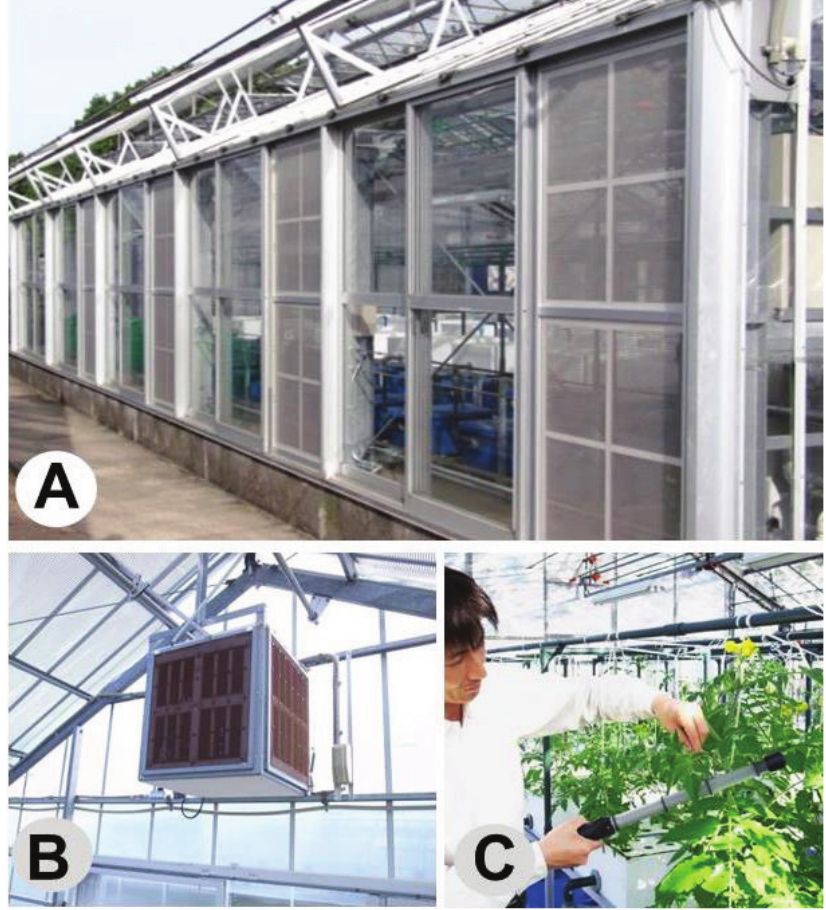
Figure 3. Electrostatic devices used in this study. ( A ) SD screens attached to the lateral-window frames of room B of the divided greenhouse, shown in Figure 2. ( B ) A box of SD screens used to cover an extractor fan in room B. ( C ) An electrostatic insect sweeper operated by a researcher during the routine care of tomato